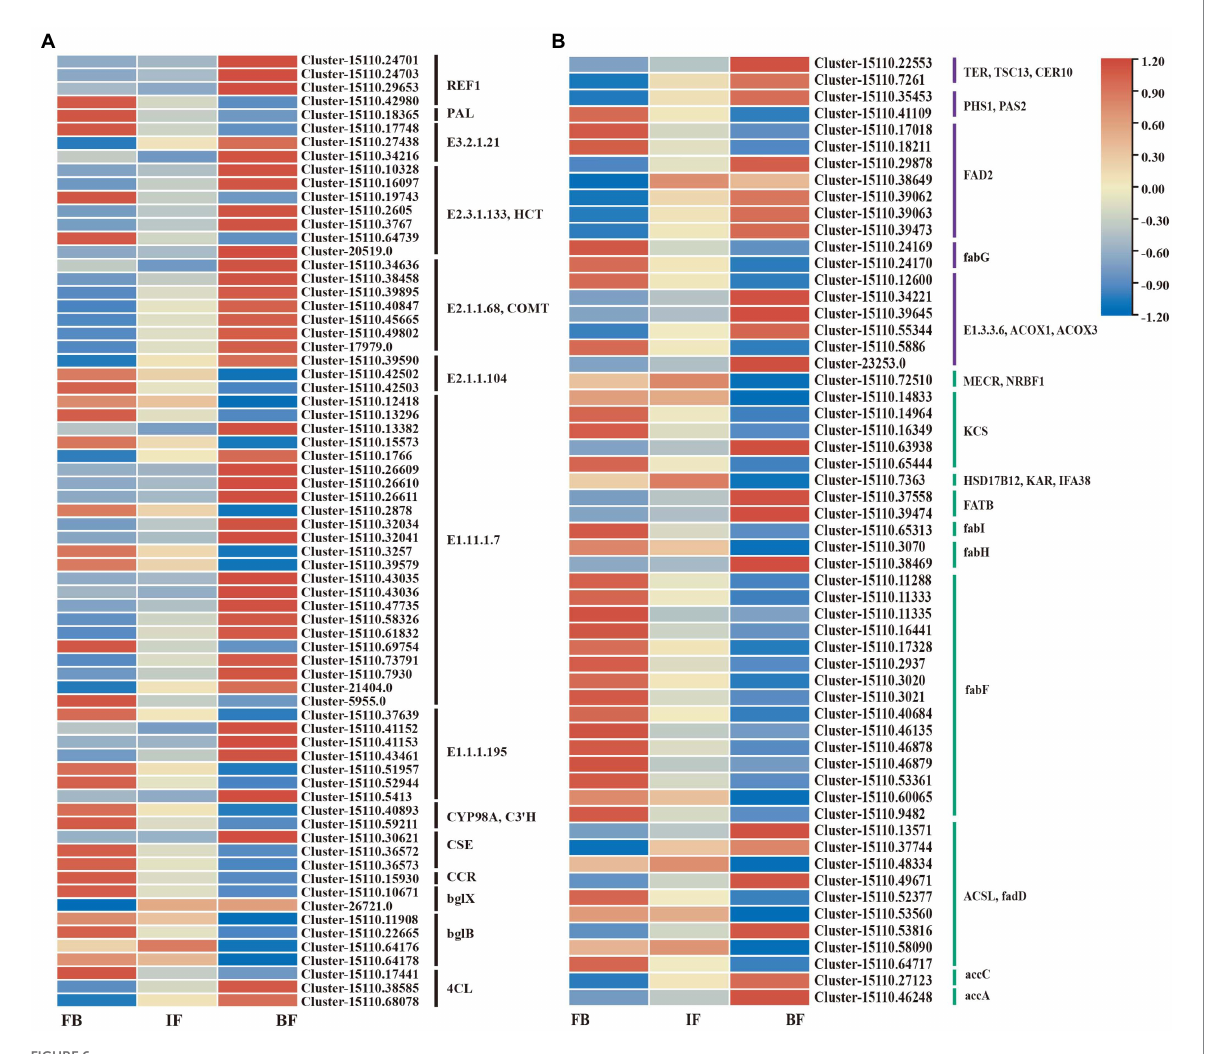
gene expression profiles from RNA-Seq data were reliable and